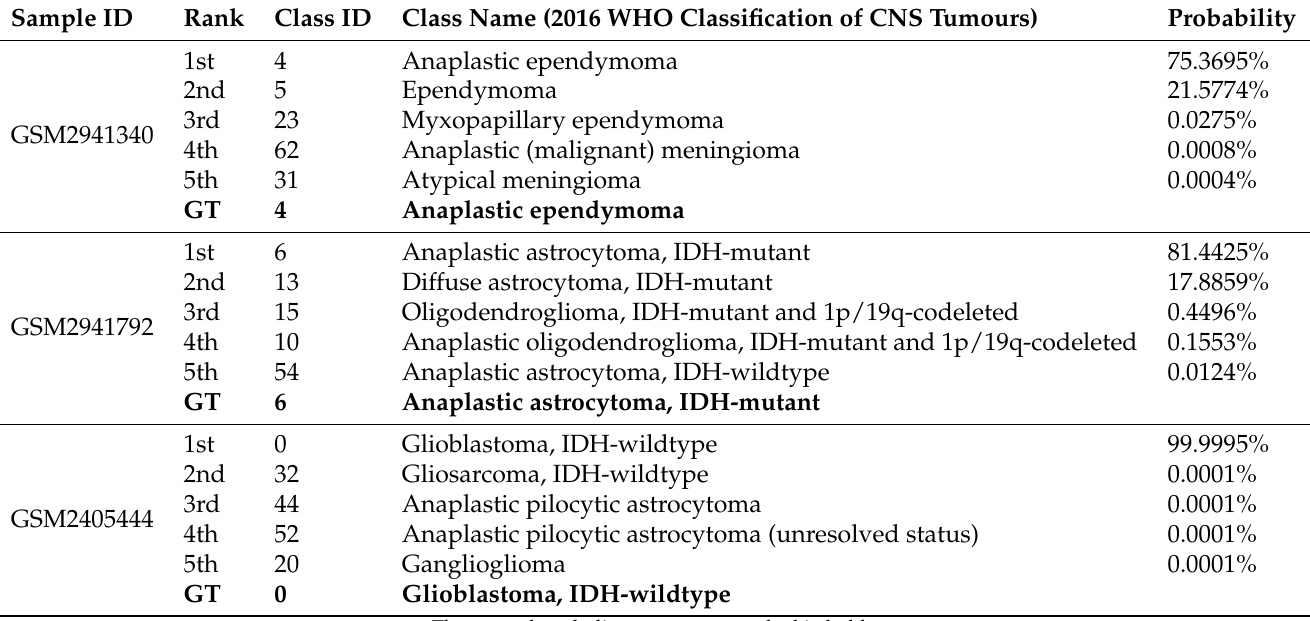
Table 3. Three output examples from the testing set of histopathological tumour type classification on the BTM dataset. Ground truth (GT) is the pathological diagnosis made by clinicians.